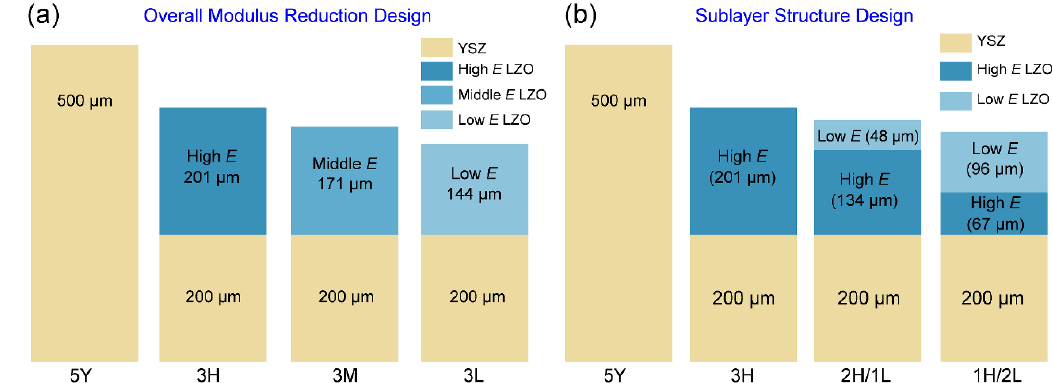
Fig. 58 Multilayer design for long life span TBCs: (a) overall modulus reduction design and (b) sublayer structure design. Reproduced with permission from Ref. [353], © Elsevier B.V. 2019; Ref. [354], © Elsevier Ltd. 2018.